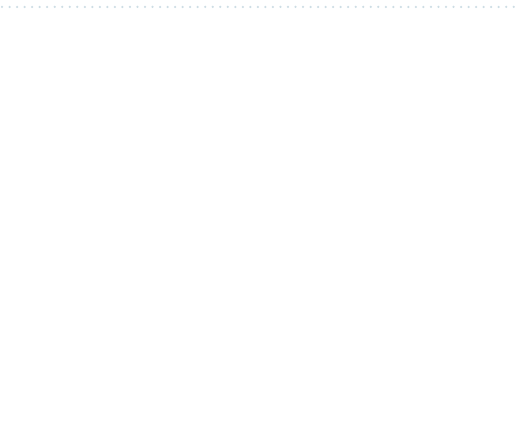
Figure 4. Yields, in atoms, for isotopes of interest from 1 eμA of 72 MeV 16 O bombarding a nat Cu target for 1200 s. The x-axis is seconds from start of irradiation, and the vertical grey line indicates the end of irradiation. Isotopes are labeled with their half-lives.